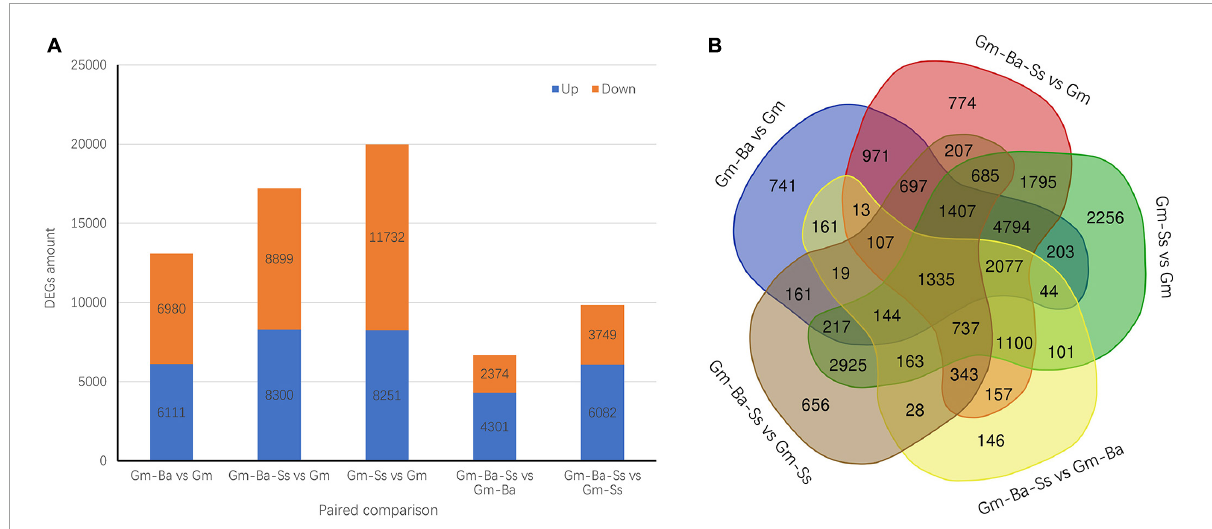
FIGURE3 Differentially expressed genes (DEGs) in five paired comparisons. (A) The DEGs amount from five paired comparisons. (B) Venn diagrams of DEGs from five paired comparisons. Gm-Ba, G. max seedling inoculated with B. amyloliquefaciens ; Gm-Ss, G. max seedling inoculated with S. sclerotiorum ; Gm-Ba-Ss, G. max seedling inoculated with B. amyloliquefaciens and S. sclerotiorum ; Gm, control, scratch